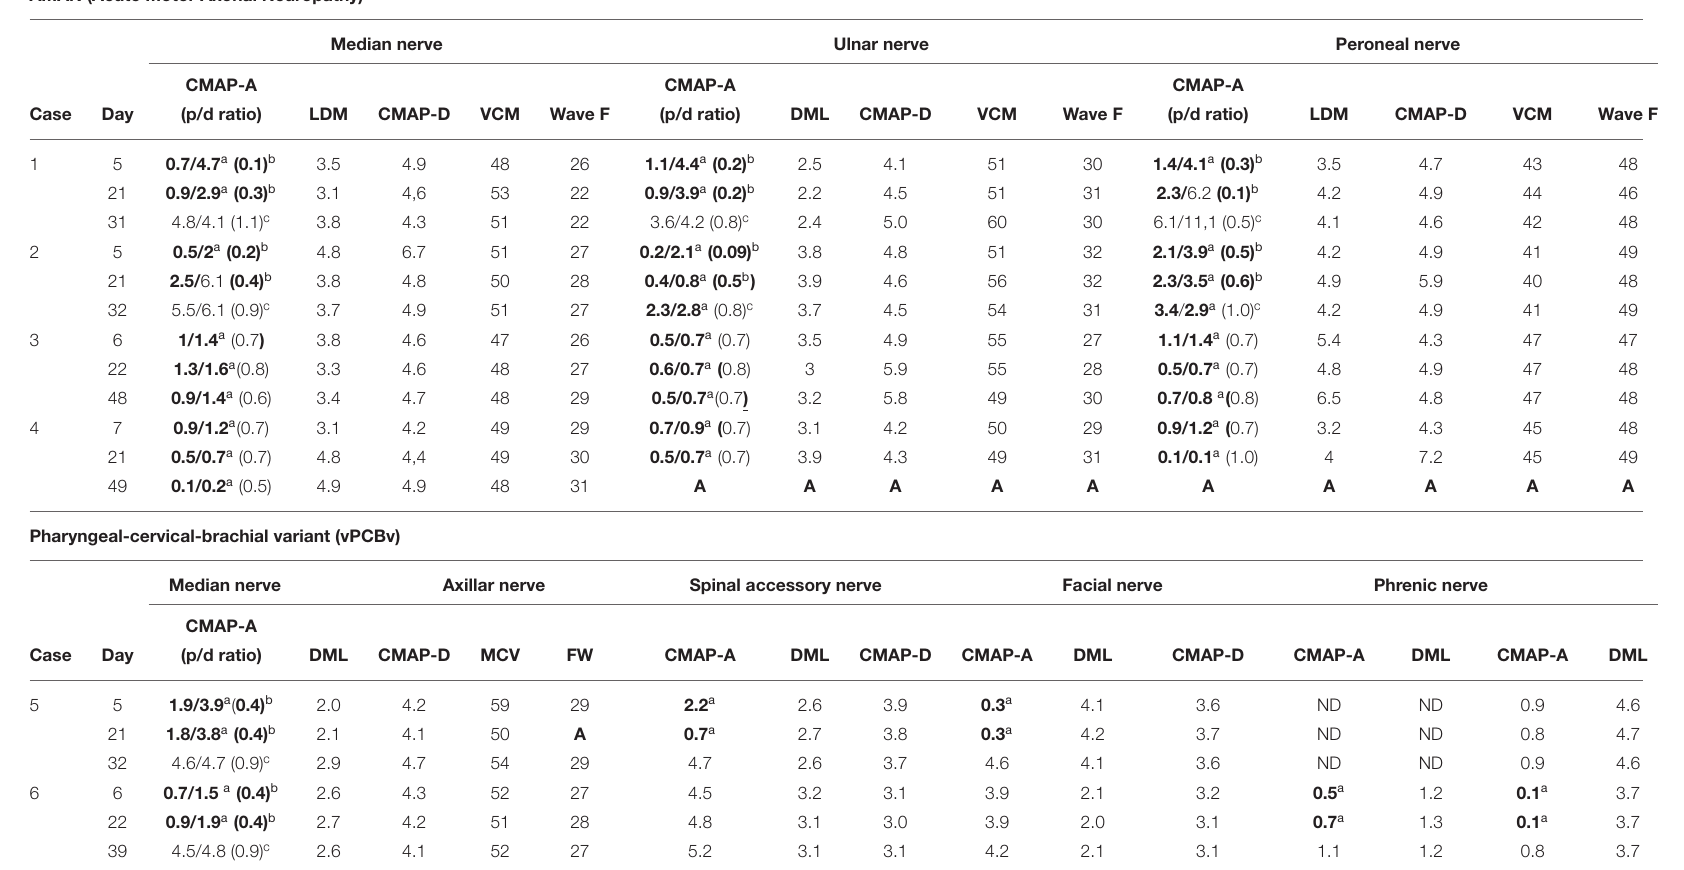
TABLE 3 | Nerve conduction studies (NCS) in all patients. AMAN (Acute Motor Axonal Neuropathy)